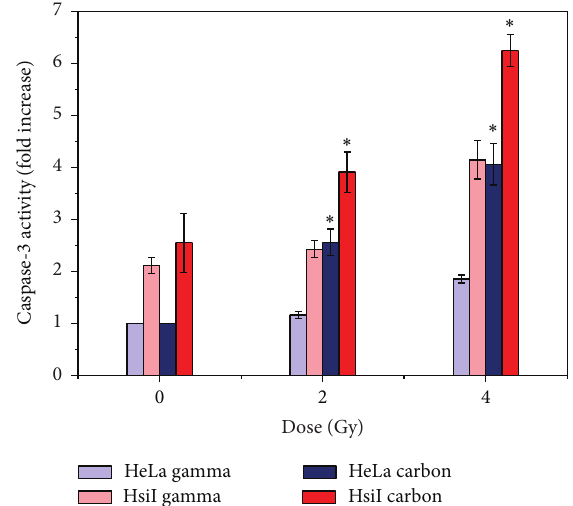
Figure 4: Induction of apoptosis detected by nuclear fragmentation after irradiation with carbon ion beam and gamma radiation in HeLa and HsiI cells after 24 h incubation. Each bar represents mean % nuclear fragmentation with standard deviation in respective cell types. 𝑃 values at each dose of both carbon ion beam and gamma radiation for each cell type were calculated using 2-tailed paired- samples t -test and denoted by “ ∗ ” (0.01 < 𝑃 ≤ 0.05) , “ ∗∗ ” (0.001 < 𝑃 ≤ 0.01) , and “ ∗ ∗ ∗ ” (𝑃 ≤ 0.001) . 𝑃 values greater than 0.05 were left blank.